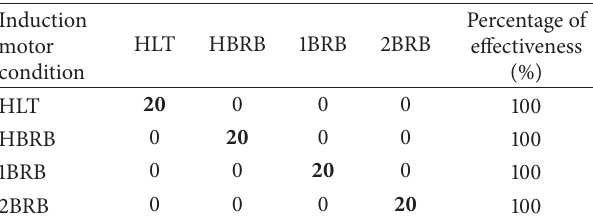
Figure 6: 𝐾 -means clusters: (a) startup transient and (b) steady state. Table 5: Classification results for steady state tests (confusion matrix).